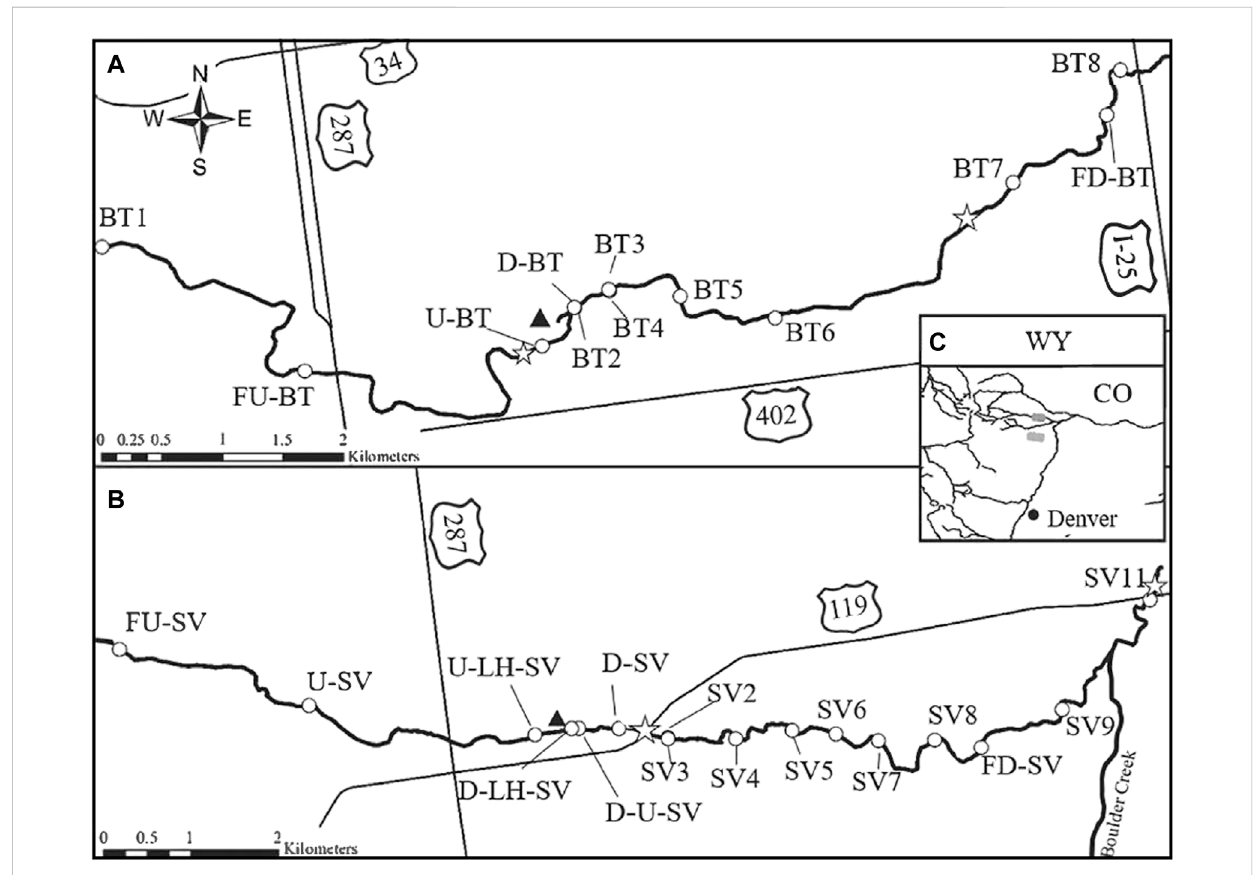
Mapoftemperatureloggerlocations(circles)inthe (A) BigThompsonRiver(BT)throughLoveland (B) St.VrainCreek(SV)throughLongmont,and (C) theirlocationrelativetotheSouthPlatteRiverBasinontheFrontRangeofColorado(greyboxes).LovelandandLongmontare74and48 kmnorthwestor Denver respectively. Lines in panel (C) show the South Platte River and its major tributaries on the Front Range of Colorado. Black triangles indicate WWTPsandwhitestarsindicatedischargegagelocations.ThedischargegageusedforsitesupstreamoftheWWTPontheSt.VrainisinHygiene,CO further upstream than the maps extent. See text for explanation of monitoring